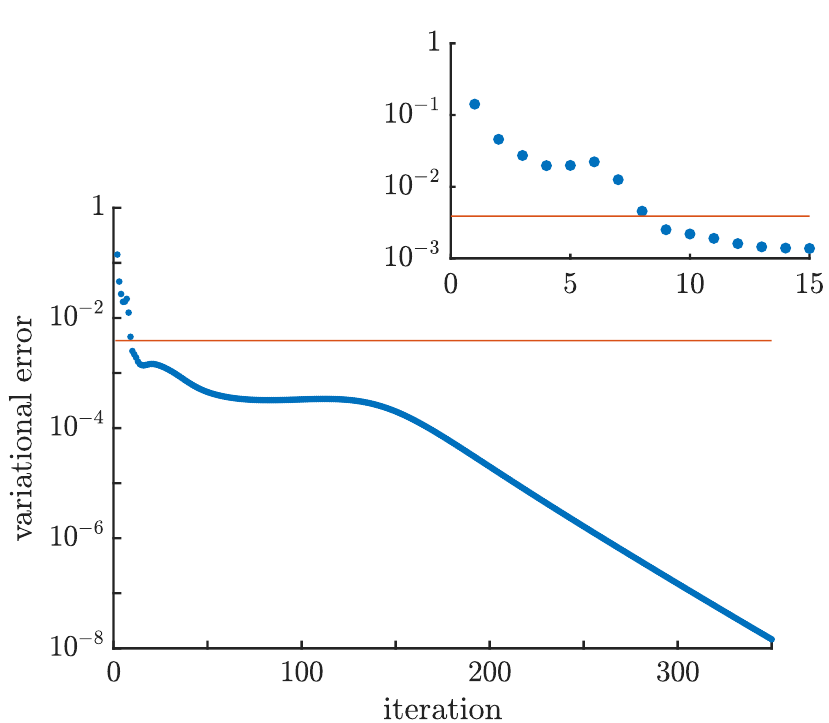
Figure 1: Truncating an MPS to a lower bond dimension. We show the variational er- ror ε [ Eq. (17) ] in each iteration of the fidelity optimization (blue), compared to that same variational error measure computed for the state obtained by a local singular- value truncation (red). After eight iterations the variational error is smaller, but we can converge a lot further using our iterative scheme. The fidelity per site λ with the original state is 1 − 5.37 × 10 − 5 and 1 − 3.78 × 10 − 5 respectively, showing that we can improve the state with our variational scheme. The starting MPS is an SU ( 2 ) - symmetric ground-state approximation for the spin-4 Heisenberg model (which has very large correlation length [ 20 ] ) with 13 charge sectors and maximal bond dimen- = 512, yielding a total bond dimension of D ≈ 21600; sion in each sector D max total this state was obtained using the vumps algorithm. The truncated MPS has 8 charge = 27, yielding a total bond dimension of D ≈ sectors with D max total